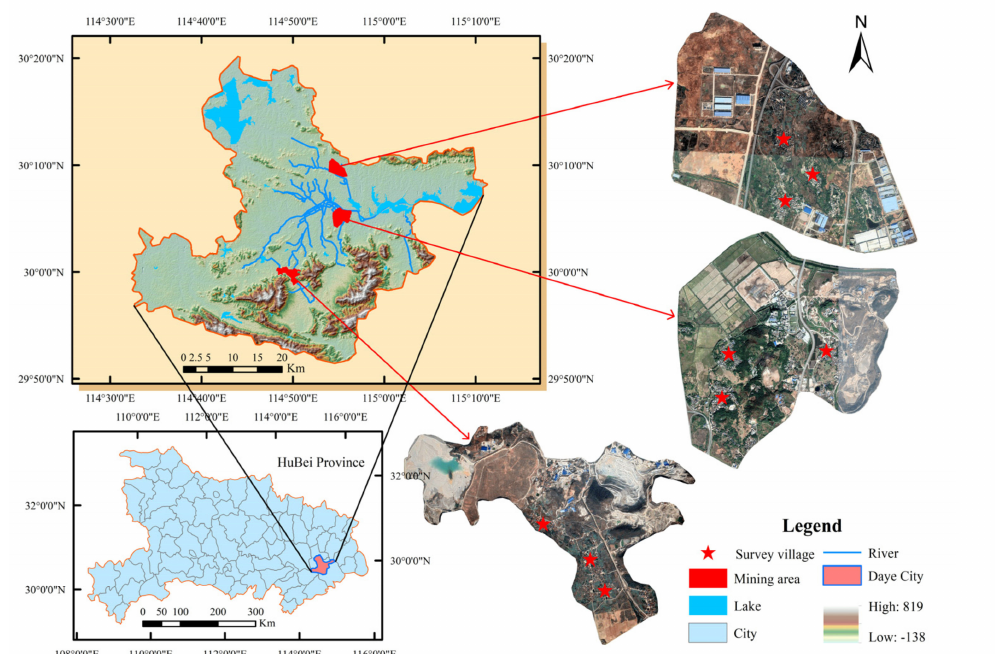
Figure 2. The location of the study